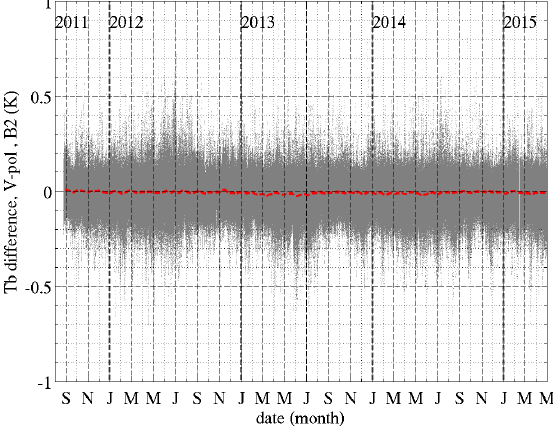
Figure 7. Differences in Aquarius TB due to differences between OSTIA and NOAA OI versus time, for the middle beam in vertical polarization. The TB difference is (grey) for each Aquarius 1.44 second footprint and (red) averaged globally over seven days.